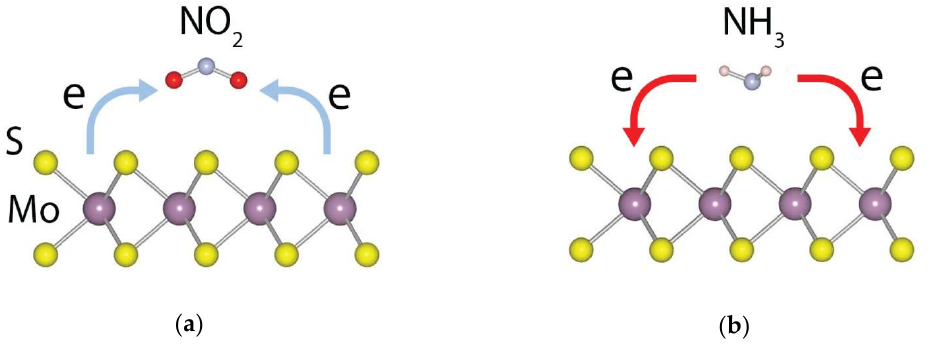
Figure 3. ( a ) Mechanism of electron-accepting NO 2 gas molecule on MoS 2 surface and ( b ) mechanism of electron-donating NH 3 gas molecule on MoS 2 surface (Reproduced with permission from [113]. Copyright 2015 Springer Nature Limited CC BY-NC-ND 4.0).